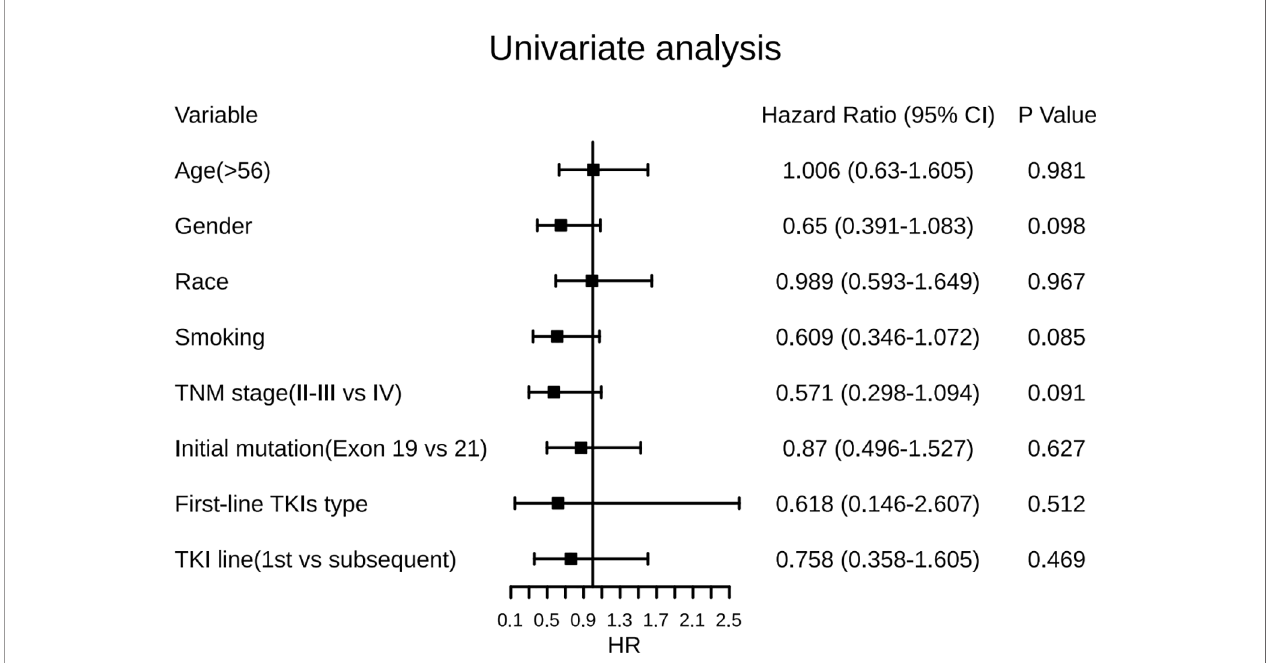
( Figure 7 ), of which 15 cases have PFS for no more than 3